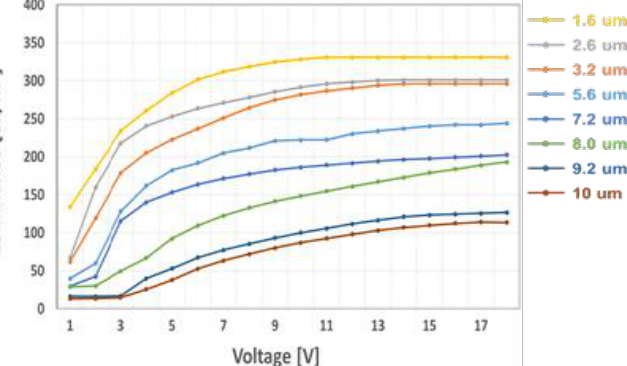
Figure 5. Measured voltage-luminance of the polarized mode LC cell as a parameter of cell gap at 6.2 wt % of the dichroic dye concentration.